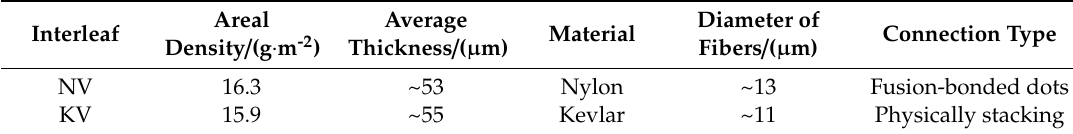
Table 2. Structural characteristics of the two veil interleaves.